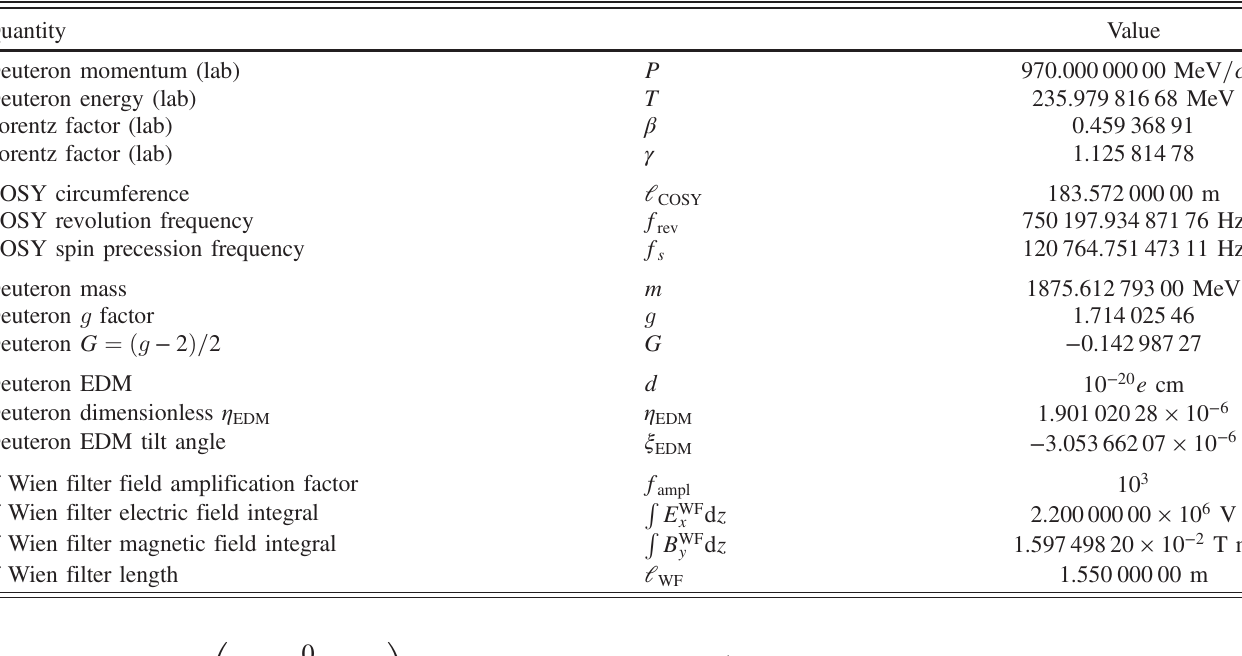
TABLE I. Parameters of the deuteron kinematics, the COSY ring, the deuteron elementary quantities, the electric dipole moment (EDM) assumed, and the field integrals of the idealized rf Wien filter (to eight decimal places). The deuteron momentum P is used to specify the deuteron kinetic energy T , and the Lorentz factors β and γ . The COSY circumference l is used to specify the COSY COSY revolution frequency f and the spin-precession frequency f . The deuteron mass m and the deuteron g factor, taken from the NIST s rev database [17] (not from the most recent one), are used to specify G . The deuteron EDM d is used to quantify η and ξ EDM EDM